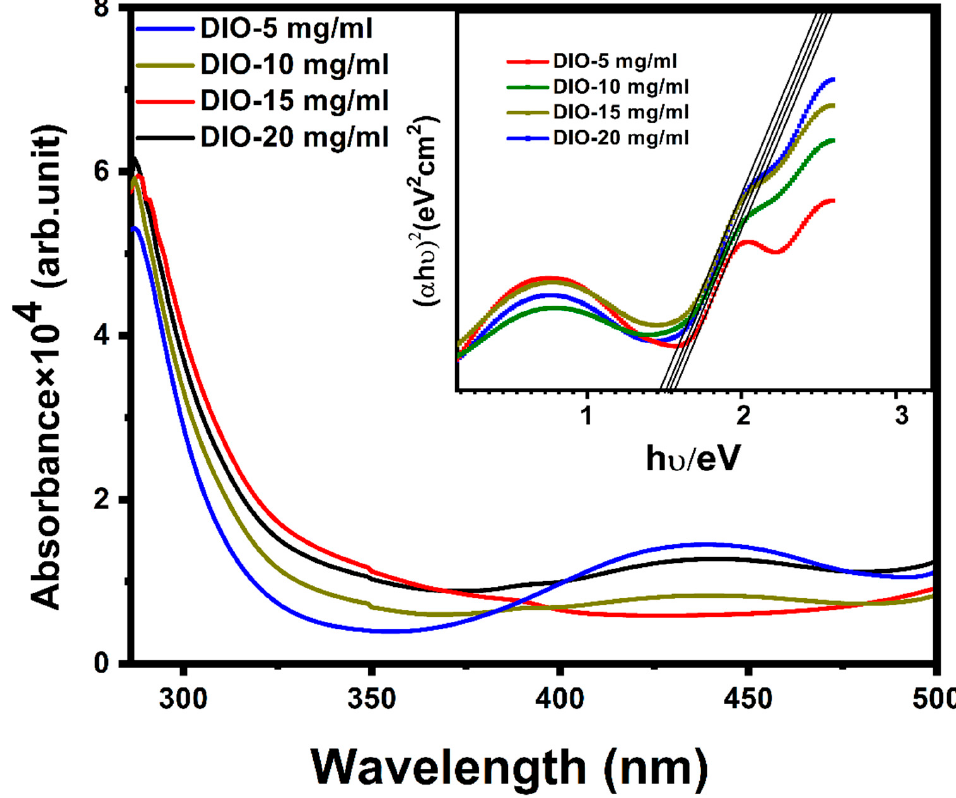
Figure 8. Absorption spectra of the typical Cu 2 ZnSnS 4 (CZTS) thin films and (inset) Tauc plots (( α h ν ) 2 vs. h ν )) for the determination of the energy gap.